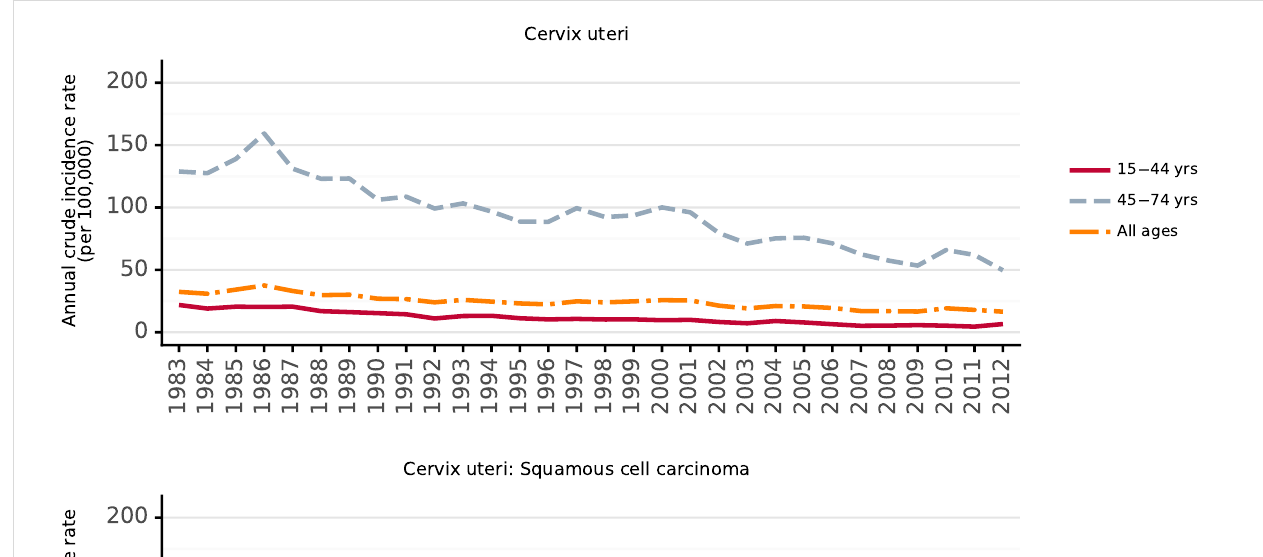
Figure 10: Time trends in cervical cancer incidence in India (cancer registry